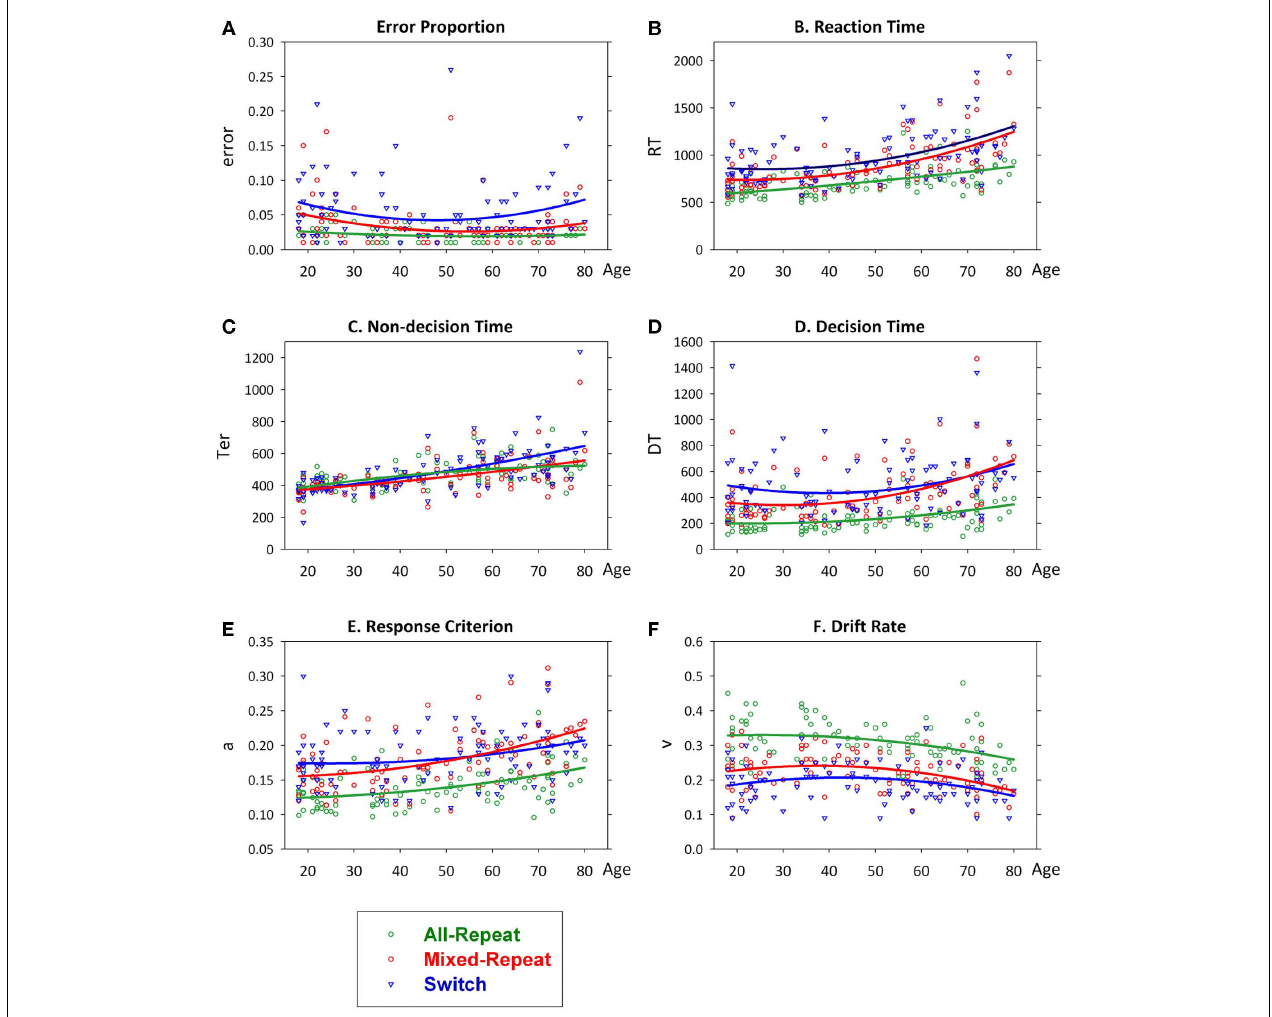
FIGURE 3 | Scatterplots of error rate (A), reaction time (B), non-decision time (C), decision time (D), criterion (E) and drift rate (F) as a function of age superimposed for each trial type with quadratic lines of best fit. Effects remained highly significant when outliers for RT,Ter, and DT were